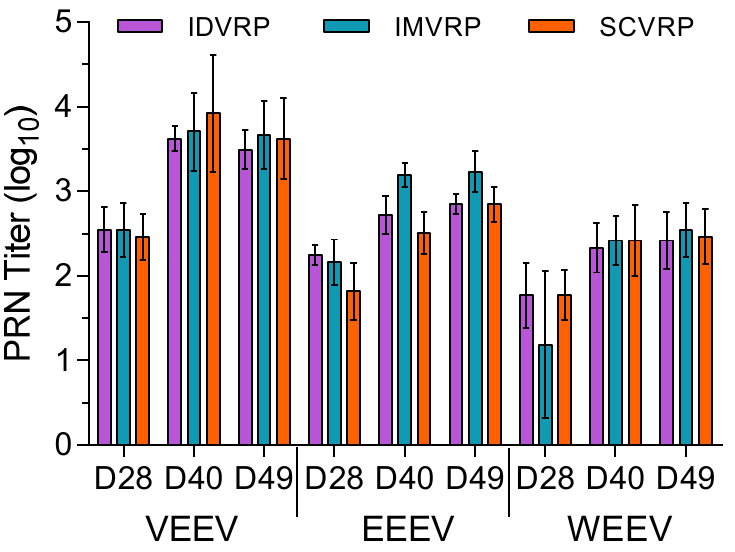
Figure 1. PRNT for sera collected from WEVEE VRP-vaccinated NHPs. Neutralization titers were measured from sera collected prior to and on days 28, 40, and 49 after primary vaccination. Neu- tralizing antibody levels against VEEV, EEEV, and WEEV were assessed. There were no detectable serum neutralizing antibodies in the pre-vaccination or CTRL (PBS) vaccinated NHP sera tested ( n = 7 WEVEE VRP NHPs and n = 6 CTRL NHPs for each challenge virus). Error bars represent ± SD.